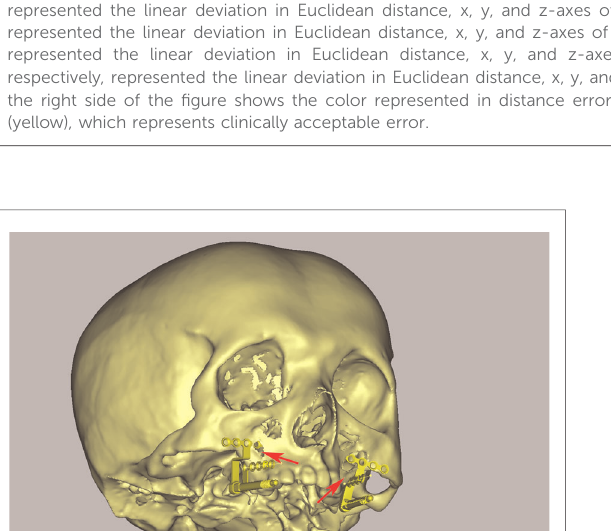
FIGURE 7 Abnormal position of distractors in VSP note: the limitation of VSP for distraction osteogenesis in maxillary hypoplasia, the virtual footplate could not be contoured to match the pro fi le of the maxilla, which led to the abnormal position of the footplate (red